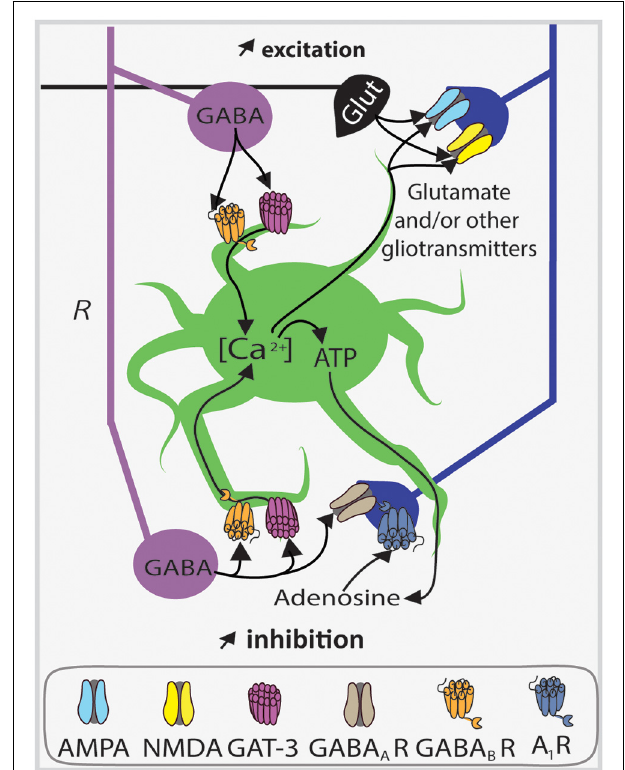
FIGURE 6 | Astrocytes upregulate synaptic inhibition and excitation of PC apical dendrites via SOM interneuron GABA release. Diagram of endogenous astrocyte-mediated positive feedback autoregulation of SOM interneuron (violet) dendritic inhibition of CA1 PCs (blue) and putative regulation of excitatory inputs. Astrocytes (green) sense GABA release through the GABA transporter GAT-3 and GABA B Rs which induce an increase in astrocyte calcium concentration ([Ca 2+ ]) leading to the liberation of ATP in the extracellular compartment. After its release, ATP is converted into adenosine, which then activates pyramidal cell adenosine 1 receptors (A 1 Rs). Activation of these receptors enhances SOM interneuron synaptic inhibition by a mechanism leading to gain of function of postsynaptic GABA A Rs. Parallel to this mechanism, as a consequence of Ca 2 + rise, astrocytes can probably release other gliotransmitters like glutamate to coordinate different synapses (black, excitatory synapse). Abbreviations: Glut, Glutamate; R, radiatum